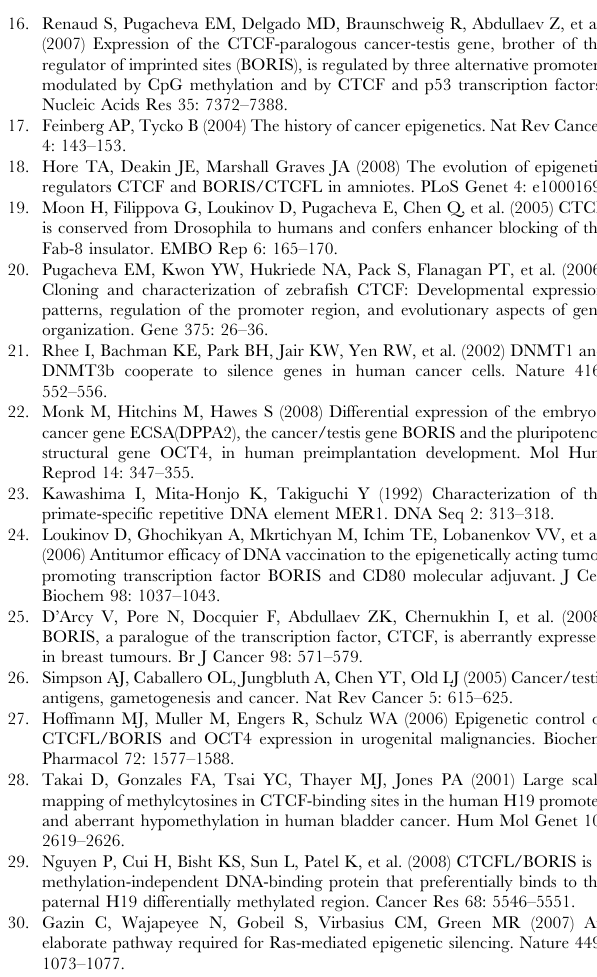
Table S2 The primers and the Tagman probes used in qRT- PCR.